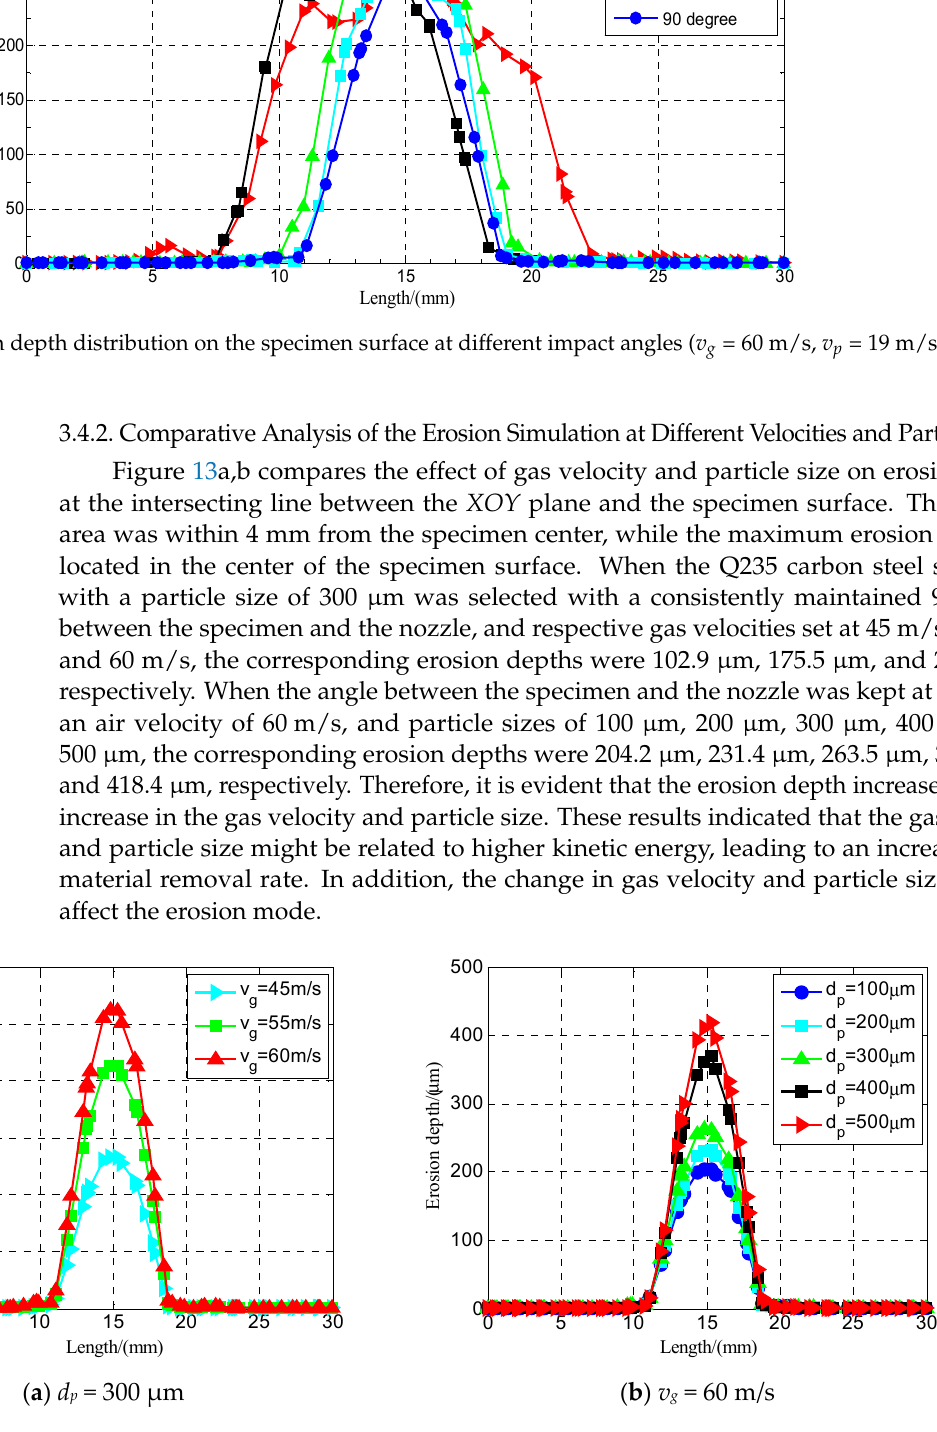
Figure 13. A comparison of the erosion depth at different velocities and particle sizes ( θ = 90°). ( a ) Depth erosion at different air velocities ( d p = 300 μ m) . ( b ) Erosion depth at different particle diameters ( v g = 60m/s).